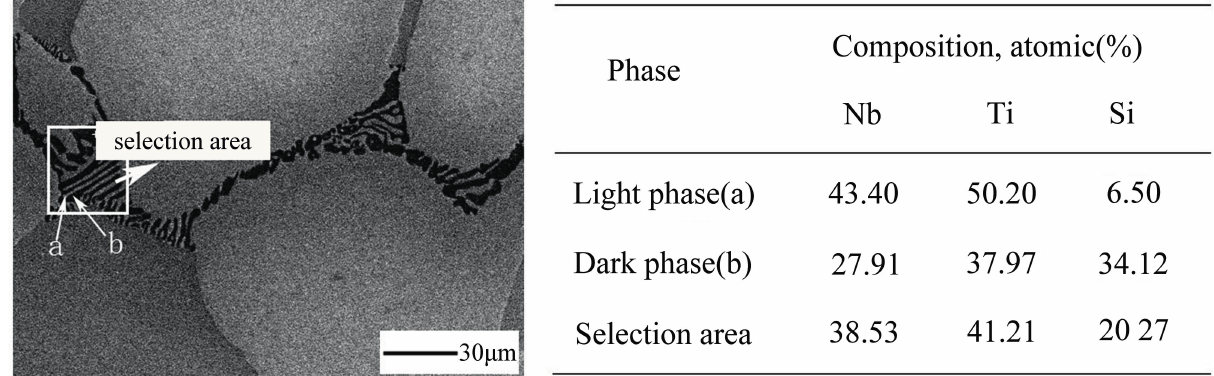
Figure 2. The microstructure of the eutectoid on transverse section of the DS sample withdrawn at 1.2mm = min and the EDS results.